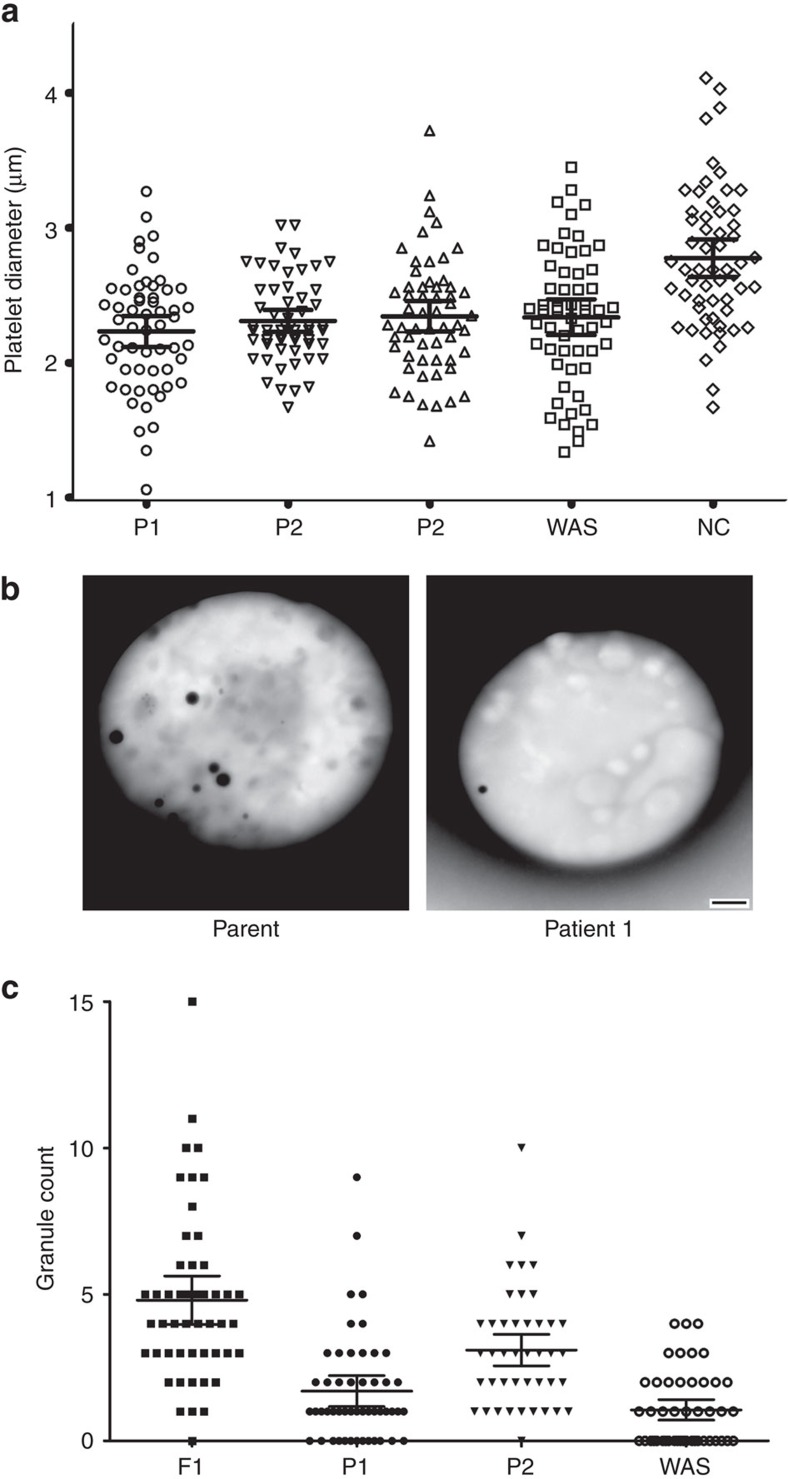
ARPC1B-deficient platelets are microthrombocytes containing decreased numbers of dense granules.(a) A comparison of platelet circumferential ring diameter distributions for all three ARPC1B mutant patients (P1, P2, P3) and a WASP-null patient (WAS) shows that all are significantly smaller (that is, microthrombocytes) compared to platelets from a normal donor (NC; P<0.0001, unpaired t-test; n=57 platelets, means and 95% confidence intervals shown by bars). No significant differences were observed among patients. (b) TEM of platelet whole mounts from an unaffected parent (left) and Patient 1 (right), showing dense granules detectable as dark spots (bar=500 nm; × 25,000). (c) Dense granule counts derived from whole-mount TEM imaging of platelets from Patient 1 (P1), Patient 2 (P2) and a WASP-null patient (WAS) were significantly lower than for cells from an unaffected relative (F1); Mann–Whitney test P<0.0008, n=50 platelets. Means for Patient 1 and WASP null were not significantly different (P=0.07), while the mean for Patient 2 was significantly higher than for Patient 1 (P<0.0001). Means and 95% confidence intervals shown by bars.